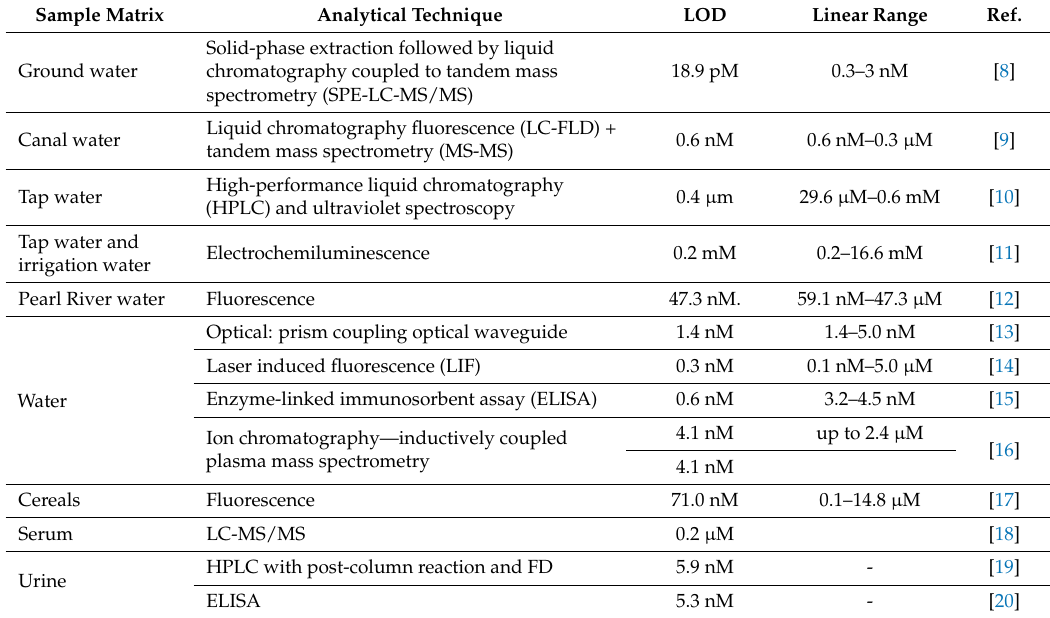
Table 1. Examples of investigated analytical methods for Gly detection and associated limits of detection (LOD) and the associated linear